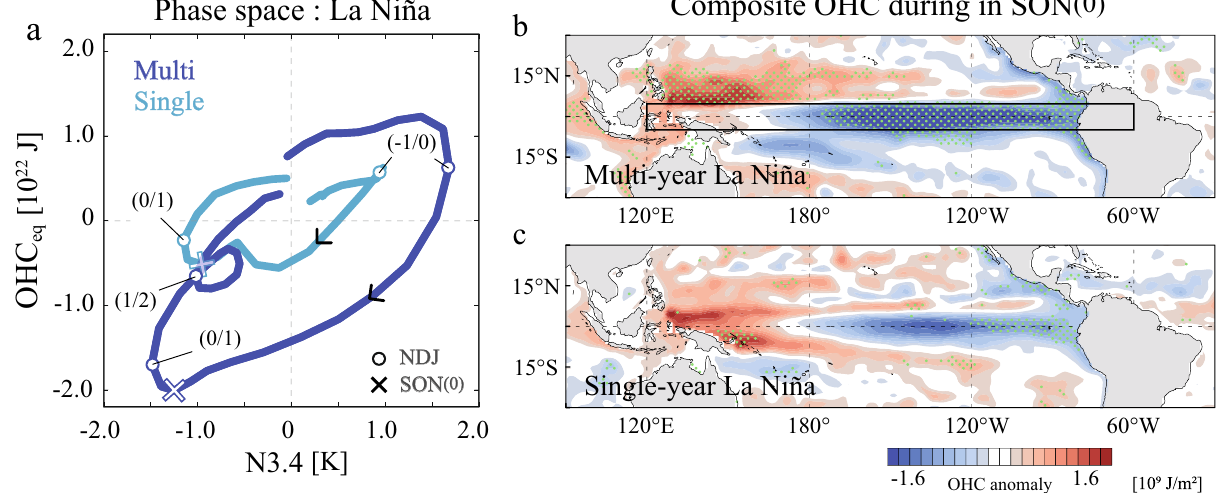
Figure 1. Comparison of the phase transition between multi-year and single-year La Niña. ( a ) Phase space diagram for observed composite multi-year (blue) and single-year (light blue) La Niña plotted for the periods preceding El Niño to the termination of La Niña. The horizontal axis is N3.4 and the vertical axis is the OHC eq anomaly. The trajectories are smoothed with a three-month running-mean. Circles denote NDJ for each year and crosses denote SON(0). ( b , c ) Multi-year and single-year La Niña composite maps of OHC anomalies integrated from the surface to 500 m during SON(0), respectively. Dots indicate anomalies statistically significant at the 95% confidence level. The box in ( b ) represents the region to calculate OHC eq . (Maps are generated by visualize module PyNGL with Python Programming Language version 3.7; https:// www. pyngl. ucar.